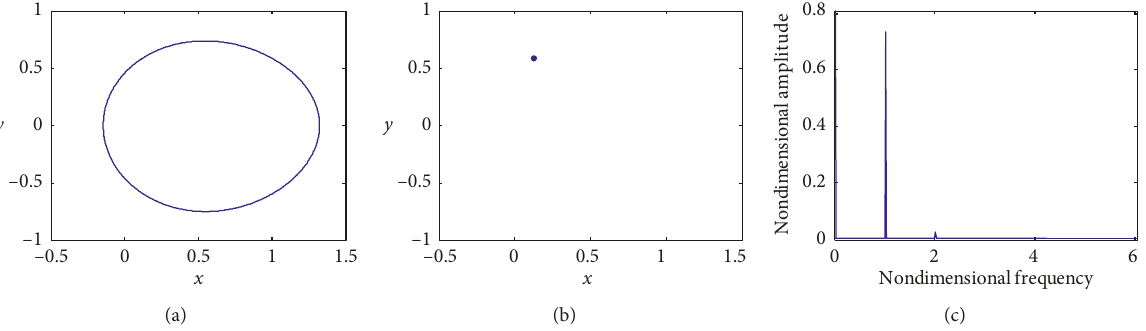
Figure 5: Dynamic response ( f � 0): (a) phase portrait; (b) Poincar´e map; (c) frequency 2